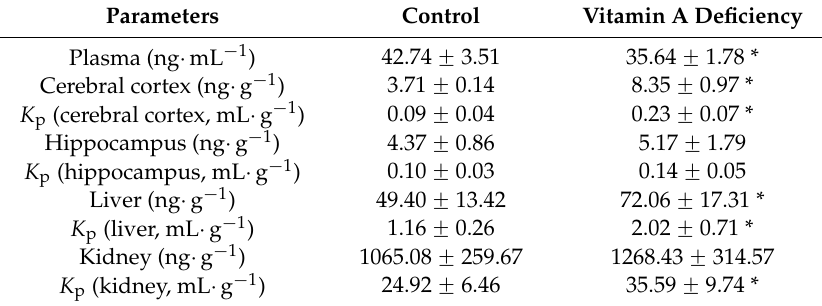
Table 2. Effects of vitamin A deficiency on rhodamine 123 (Rho123) distribution in cerebral cortex, hippocampus, liver and